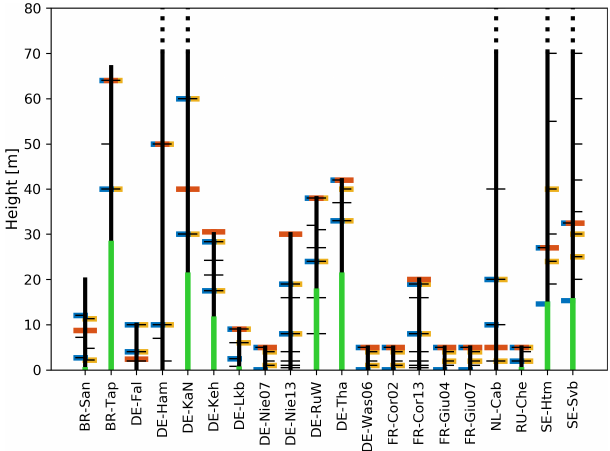
Figure 2. The schematic set-up of the meteorological towers used for this study. Available measurements for wind velocity (black, left arm) and temperature (black, right arm) are shown as well as the final measurement height that was used for wind (blue), temperature (yellow) and turbulent fluxes (red). Vegetation height is illustrated in green, and towers with a total height above 80m are clipped. (“Left arm” and “right arm” in this caption refer to horizontal arms that the instruments are mounted to on a real